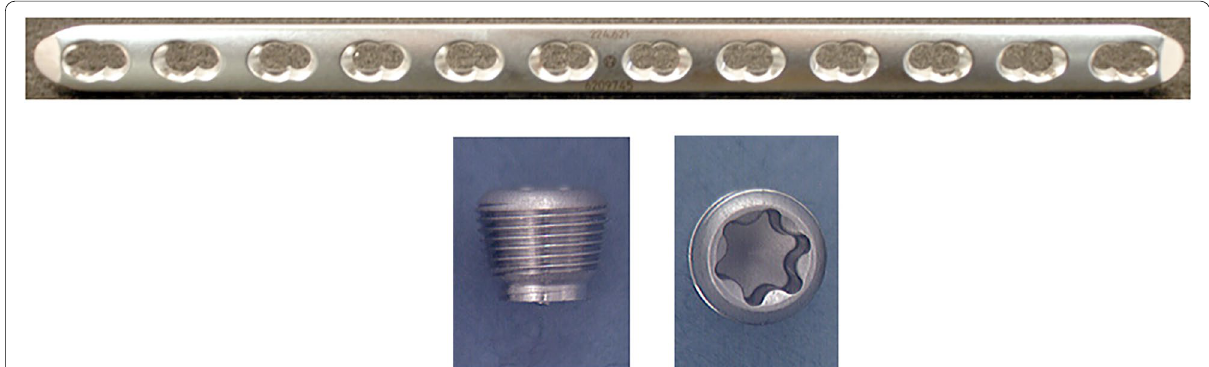
Fig. 1 Standard narrow 4.5 mm large fragment Locking Compression Plates (LCP) with Combi holes were used for all tests (top image). Locking inserts (bottom images) are similar in design to locking screws comprise only the upper aspect of the locking screw for threaded engagement with the locking plate